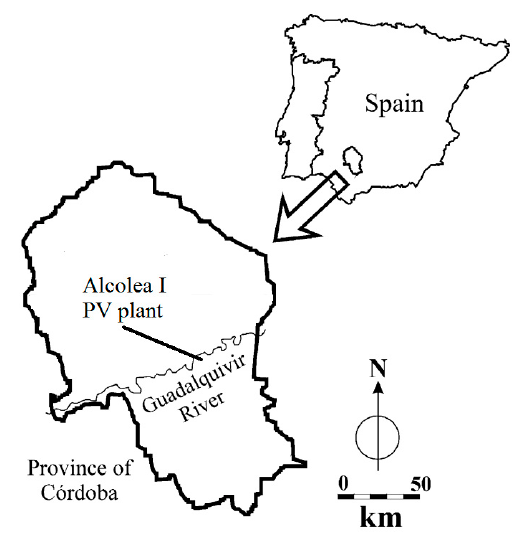
Figure 6. Area of study.